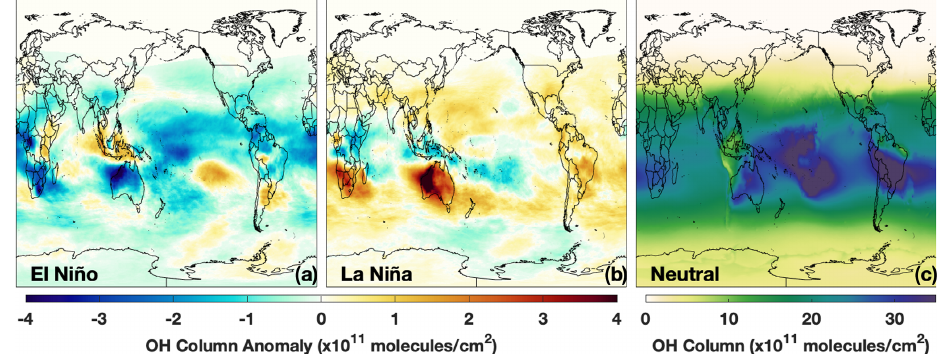
Figure 7. Absolute difference in TCOH between El Niño events and neutral events (a) for DJF, averaged over 1980–2018. El Niño and neutral events are defined as a season having an MEI value greater than 0.5 or an MEI value between − 0.5 and 0.5, respectively. The analogous plot for La Niña events (MEI less than − 0.5) is also shown (b) . Panel (c) shows the average OH column for neutral events. The 1980–2018 time period includes 11 El Niños, 12 La Niñas, and 15 neutral events in DJF. Table 2. For each season, we show the r 2 of the correlation of the temporal component of the EOF that has the highest correlation with the MEI for TCOH and for OH in each layer. In addition, we also indicate the percent (Pct.) of the total spatial variance explained by that EOF. With the exception of the values indicated by an asterisk ( ∗ ), the first EOF has the highest correlation with the MEI. Those indicated with an asterisk ( ∗ ) are the second EOF. Column UFT MFT LFT PBL Season Pct. variance r 2 Pct.